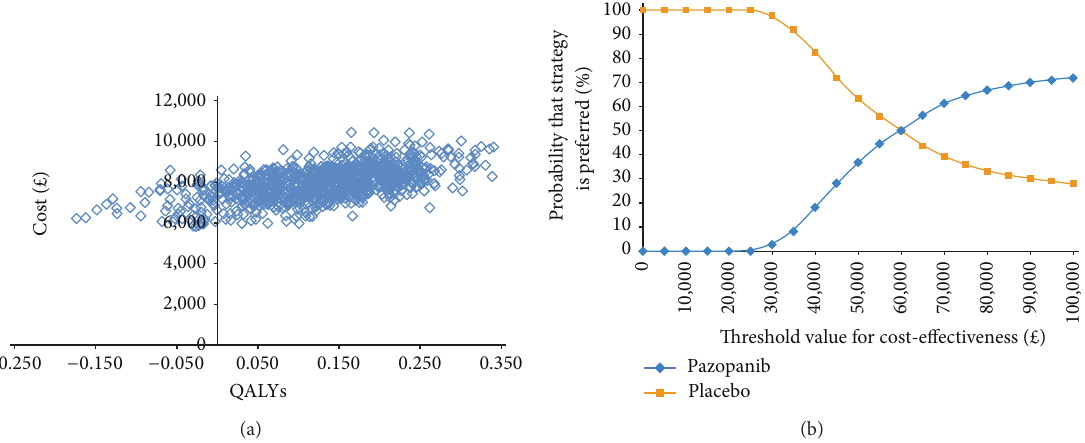
Figure 3: (a) Probabilistic sensitivity analyses for comparison of cost-effectiveness of pazopanib versus placebo. (b) Acceptability curve for comparison of cost-effectiveness of pazopanib versus placebo. QALYs: quality-adjusted